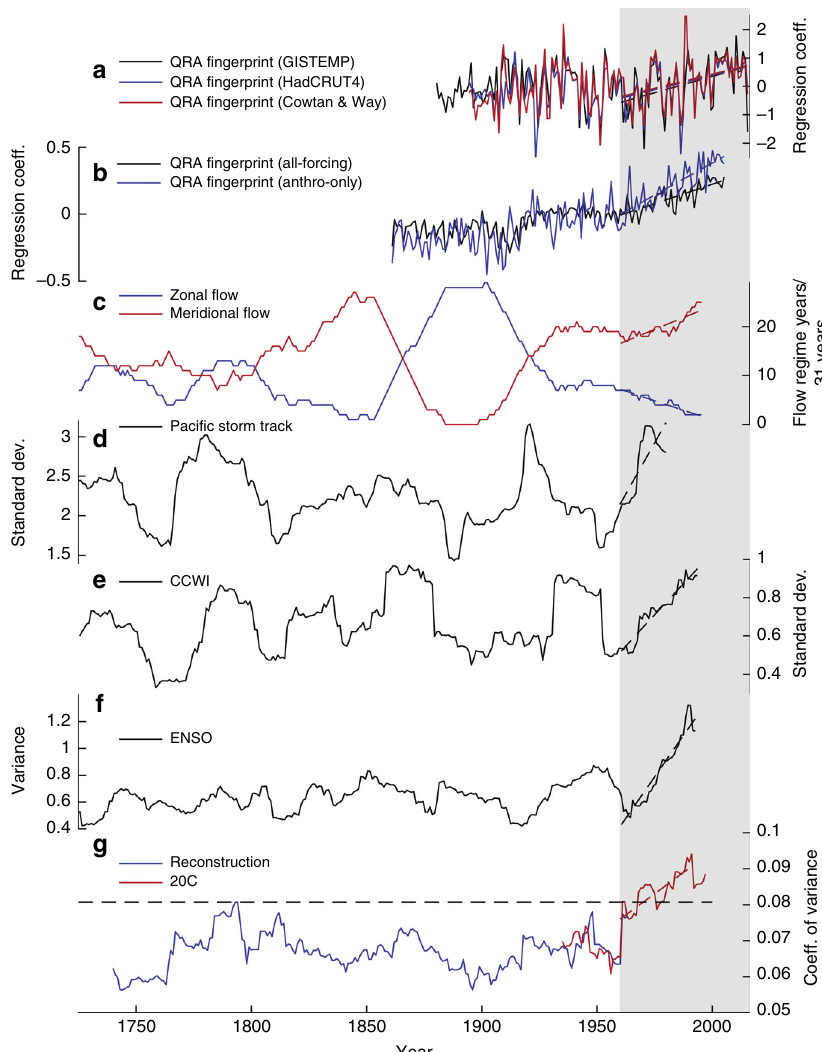
Fig. 5 Late twentieth century variance increase in North Atlantic and North Paci fi c Basin. Running (31-year window) coef fi cients of variance of August NAJ time series ( g ) are compared to time series of observed ( a ) and modeled ( b ) quasi-resonant ampli fi cation (QRA) fi ngerprint 15 , of reconstructed zonal and meridional fl ow in the North Paci fi c 36 ( c ), and of variance in the climate dynamics of the North ( d , e ) and Central ( f ) Paci fi c. Variance time series include the Paci fi c storm track 33 (31-year standard deviation; d ), California Current Winter Index 32 (CCWI; 31-year standard deviation; e ), and NIÑO4 SST index 31 (31-year variance; f ). The late twentieth century increased variance period (1960 – present) is highlighted in gray. Horizontal dashed line in g represents the highest 31-year values over the reconstruction period (1725 – 1978